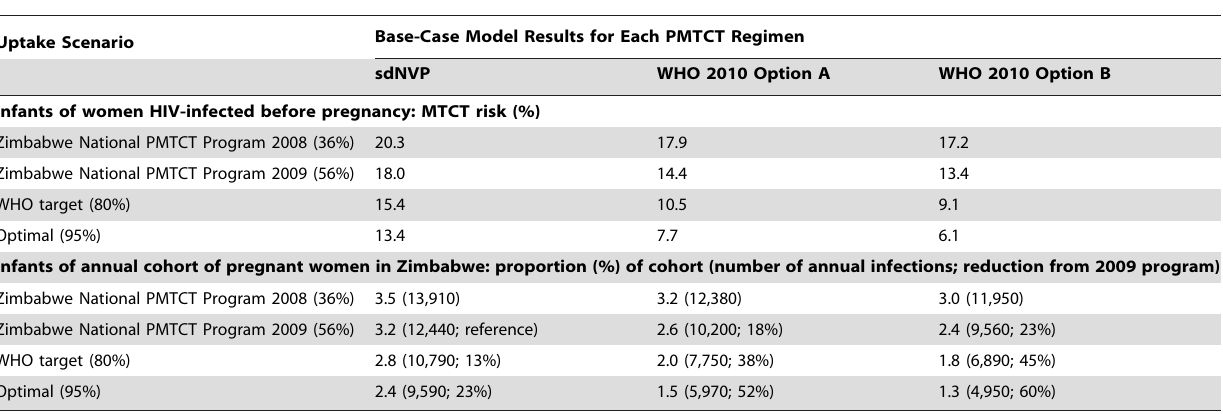
Table 5. Results of a model of PMTCT services in Zimbabwe: cumulative 12-mo infant HIV infection risks.